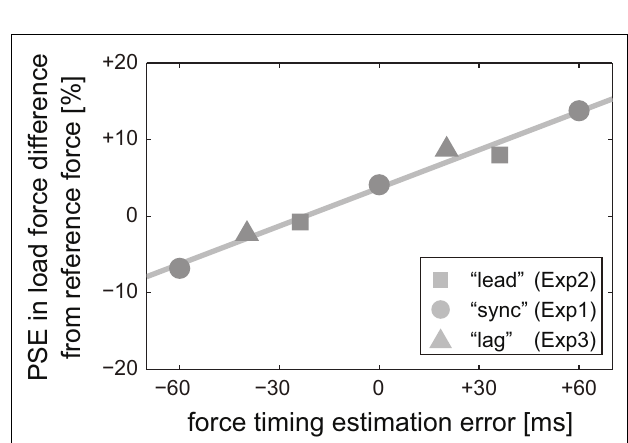
with respect to time offsets used in theWeight PerceptionTest sessions. A set of PSE shifts for both offsets is also plotted. Asterisks denote that the PSE shift was significantly greater or less than zero: * P < 0.05, ** P < 0.01.